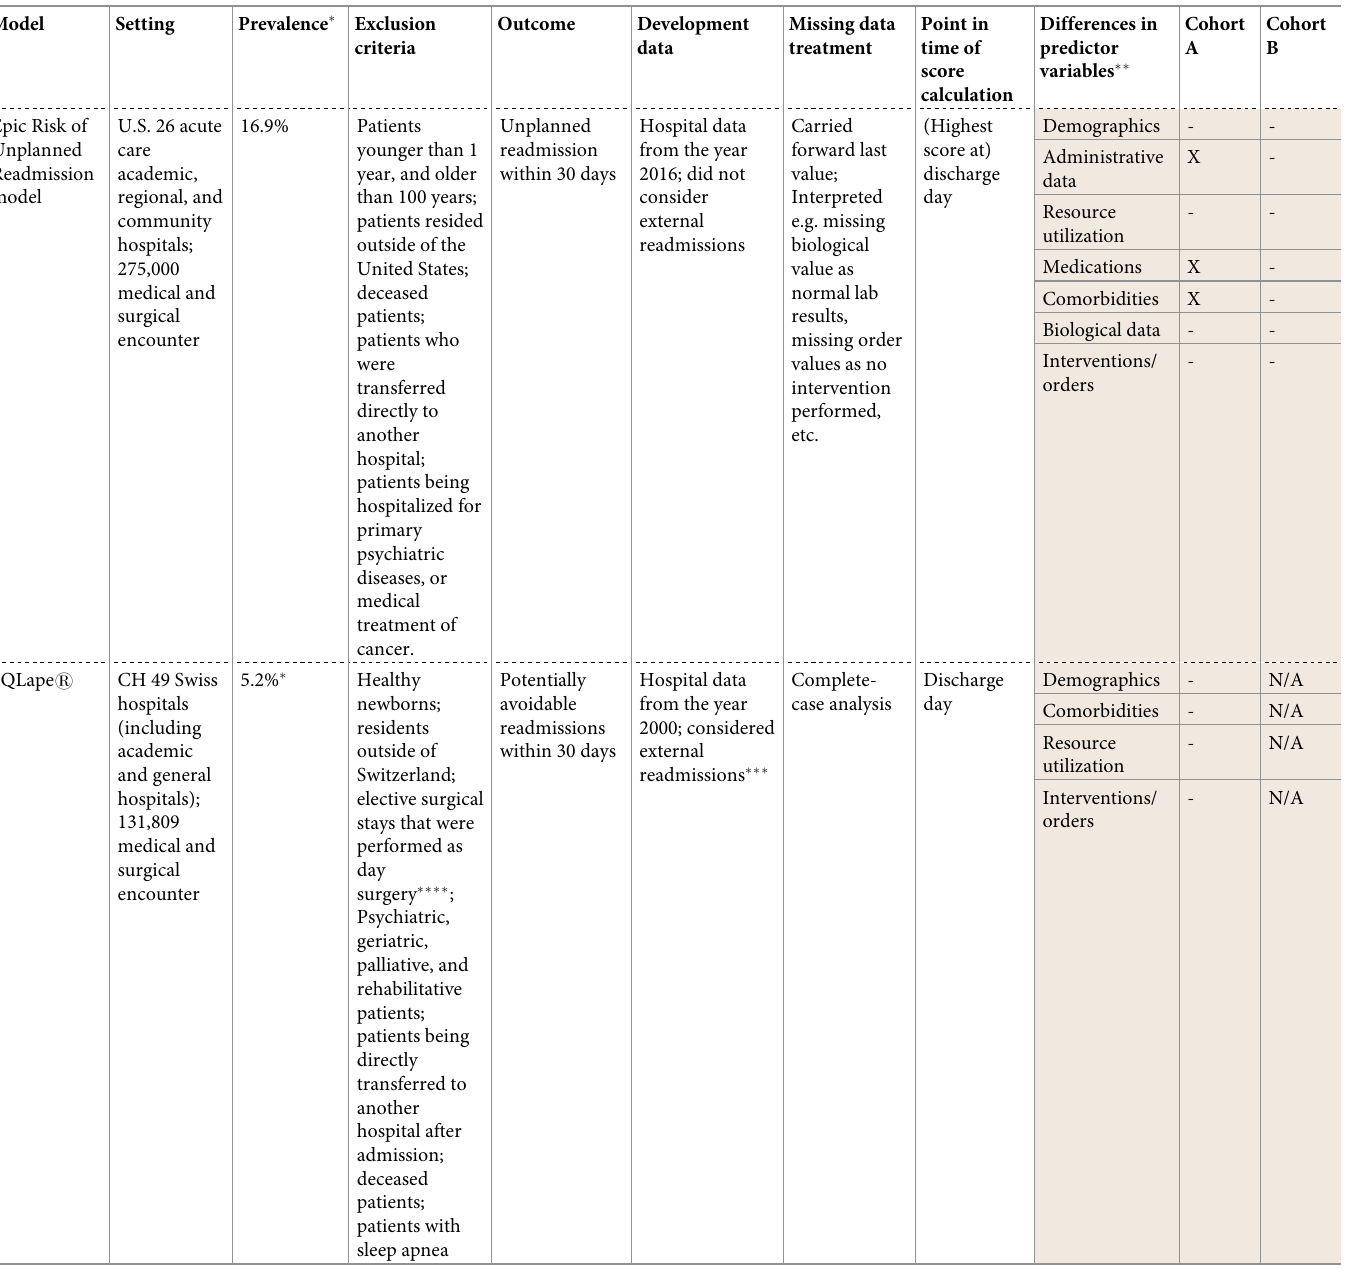
Table 2. Model transportability–summary